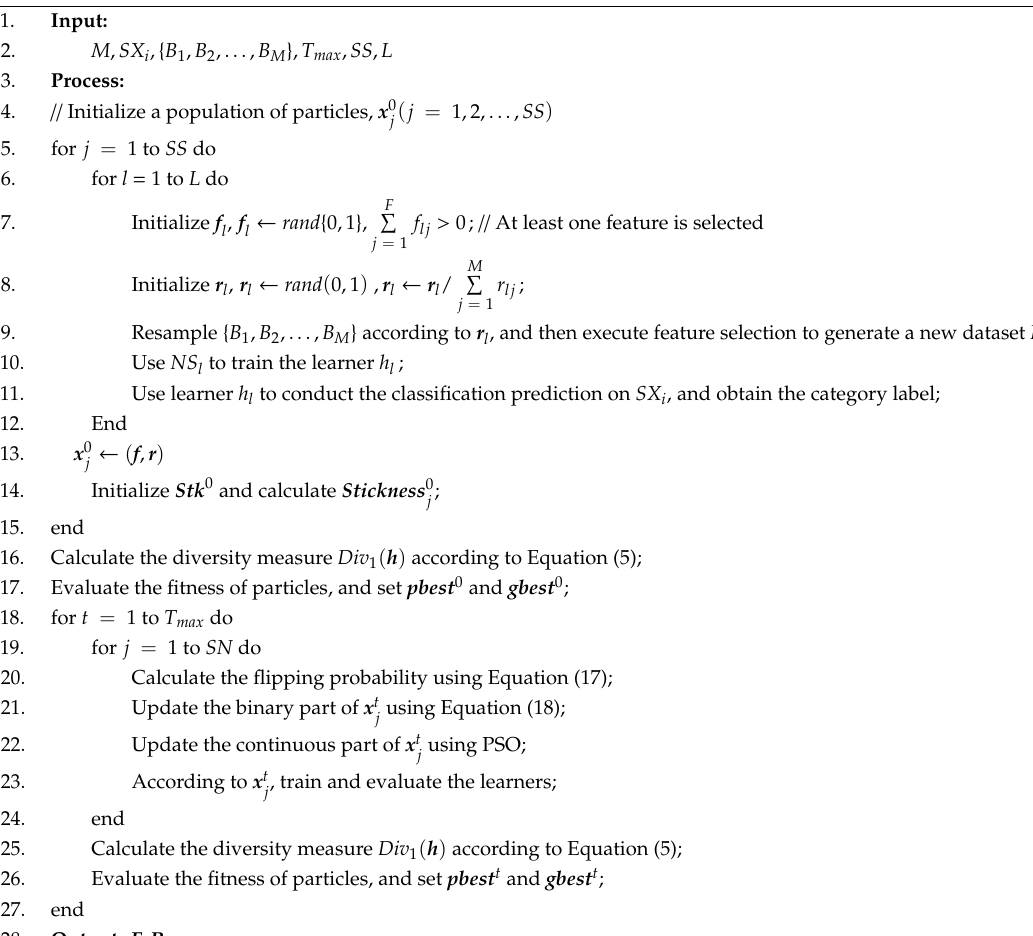
Algorithm 1. Using MPSO to optimize the resampling ratio of subset and carry out feature